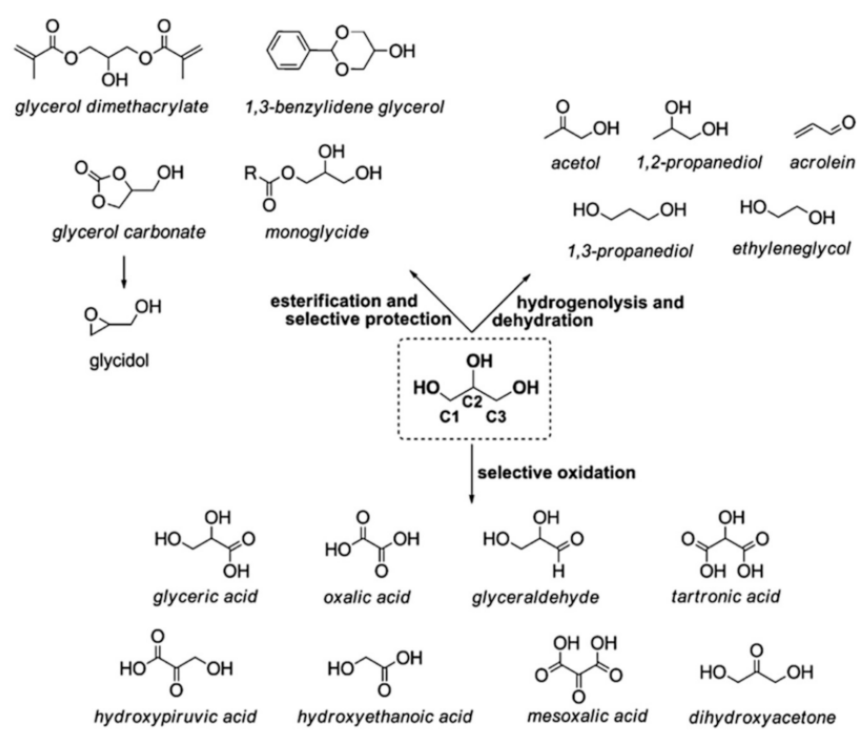
Figure 5. Conversion of glycerol into value-added compounds via different catalytic pathways